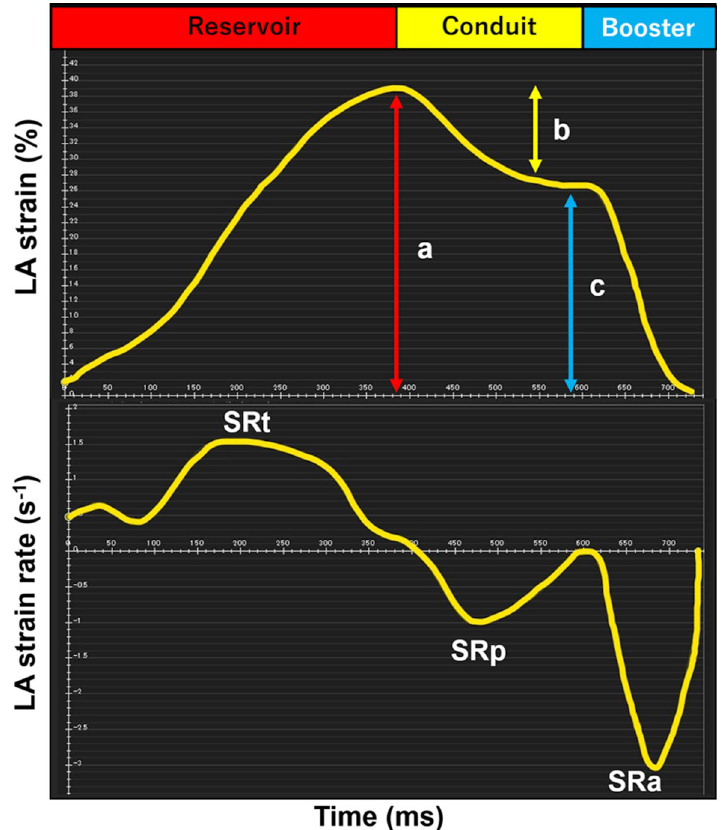
Figure 1. Quantification of left atrial strain and strain rate. Left atrial function comprised three components: reservoir function; conduit function; and booster pump function. Total strain (a) and peak positive strain rate (SRt) correspond to reservoir function. Passive strain (b) and peak early negative strain rate (SRp) correspond to conduit function. Active strain (c) and peak late negative strain rate (SRa) correspond to booster pump